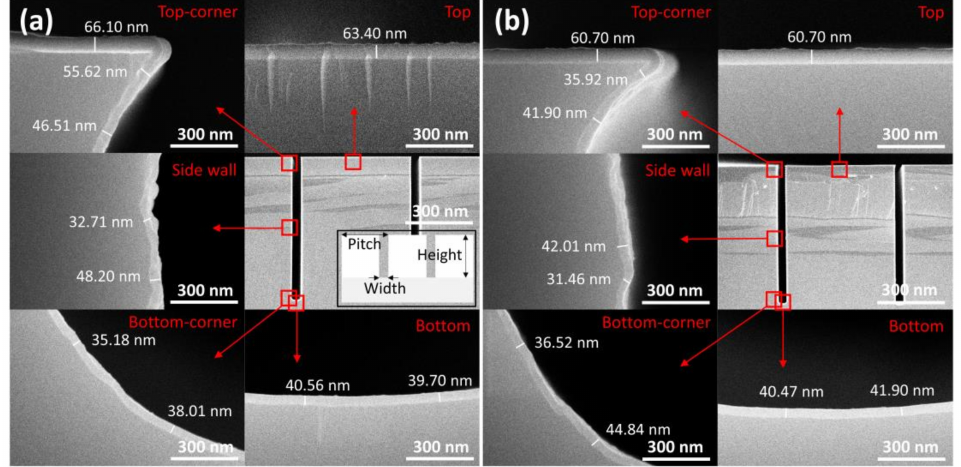
Figure 4. UHR FE-SEM images of ( a ) as-deposited and ( b ) annealed HfO 2 films at different locations in the trench. The locations where higher-magnification SEM images were captured are highlighted by red boxes and arrows. The inset of ( a ) shows the schematic of a trench patterned wafer. (Trench